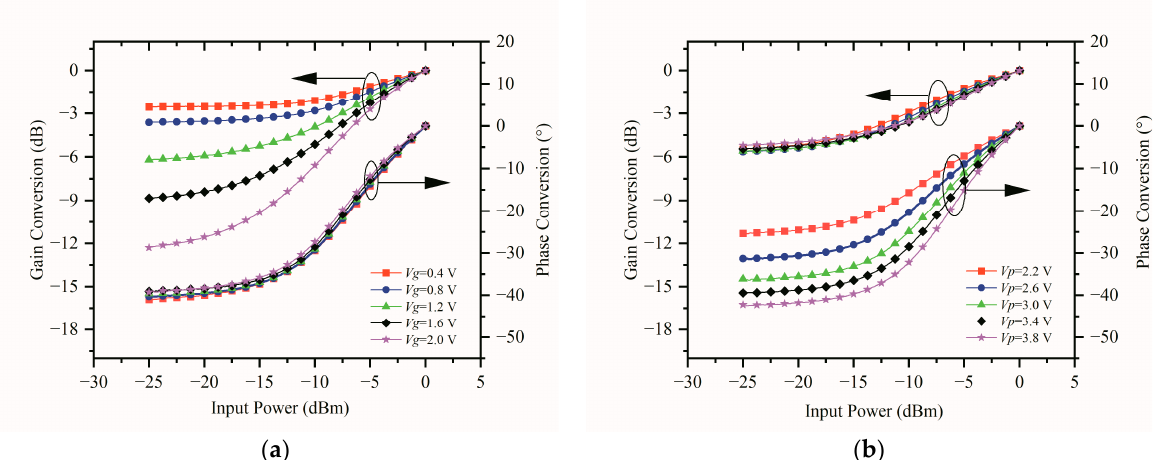
Figure 10. Measured results of independent tuning of ( a ) gain conversion and ( b ) phase conversion. During Stage 2, the APD MMIC was packaged into a Kovar casing to form a linear module. The nonlinear properties of the TWTA before and after the linear module such as gain compression and phase compression, C/IM3, and NPR were veri fi ed. It can be seen from Figure 11 that the gain compression of the TWTA cascaded with the linear module was reduced from 50° to within 12° over the whole operating band, while the gain com- pression was reduced from 8 dB to less than 3 dB, which means that the linear module compensates the nonlinearity of the TWTA very well.